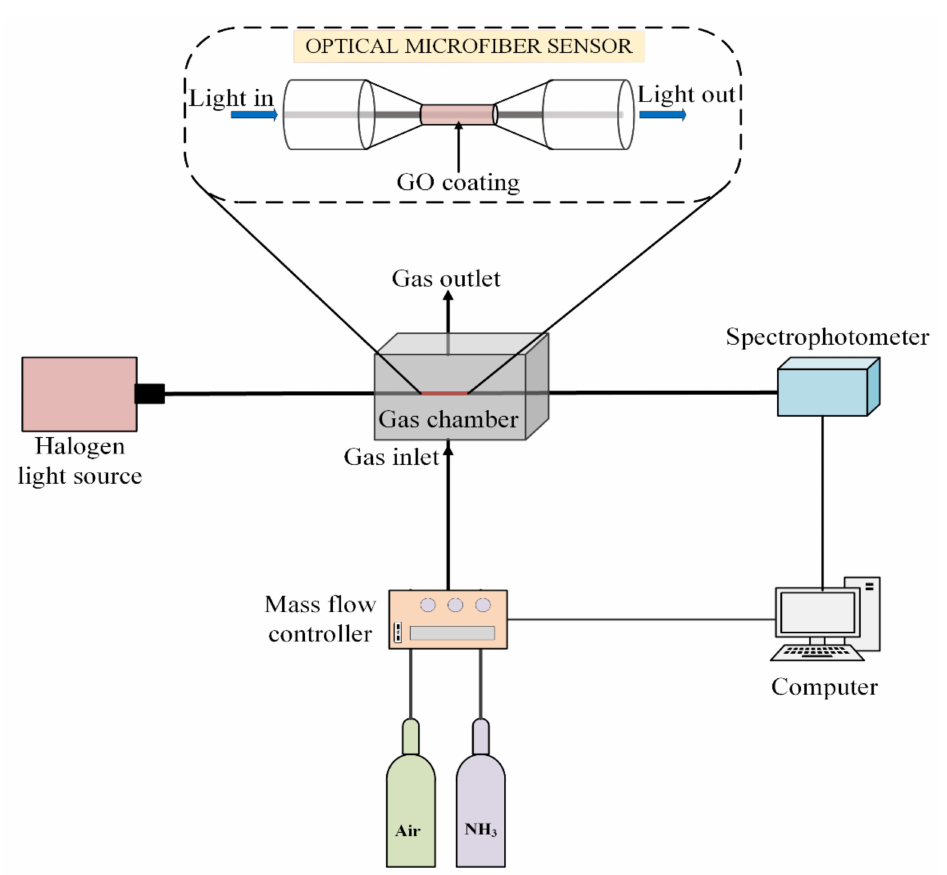
Figure 2. Schematic of the experimental setup for optical microfiber ammonia (NH 3 ) gas